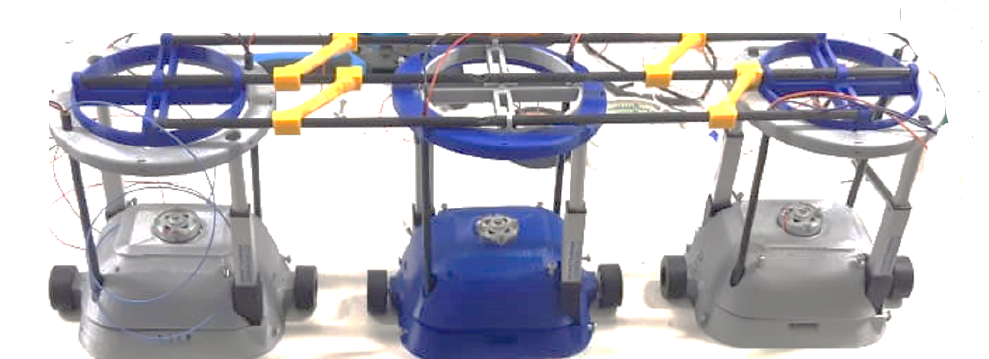
Figure 6. Prototype of